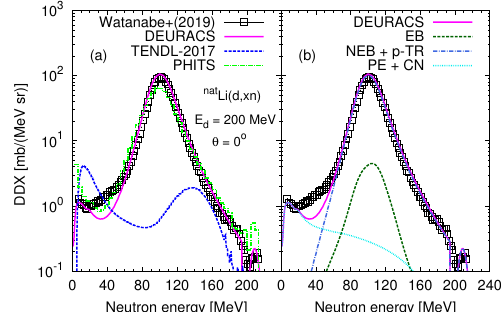
Figure 1. Calculated and experimental DDXs for the ( d , xn ) re- action on natural lithium at 200 MeV. Comparison of the DEU- RACS calculation with the experimental and other calculated data is presented in (a), and the components corresponding to each reaction process in the DEURACS calculation are shown in (b). Open squares are the experimental data taken from Ref. [19]. Note that only in the DEURACS calculation the target is assumed to be 7 Li. See text for the meaning of the curves.